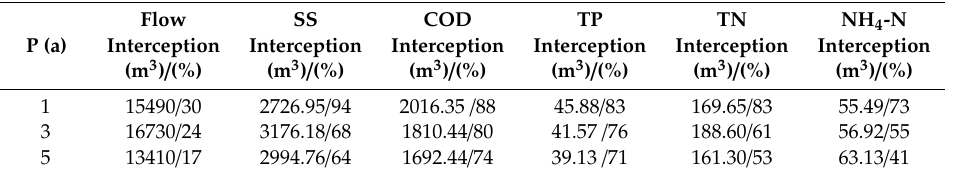
Table 9. Combined results of COD + NH 4 -N.